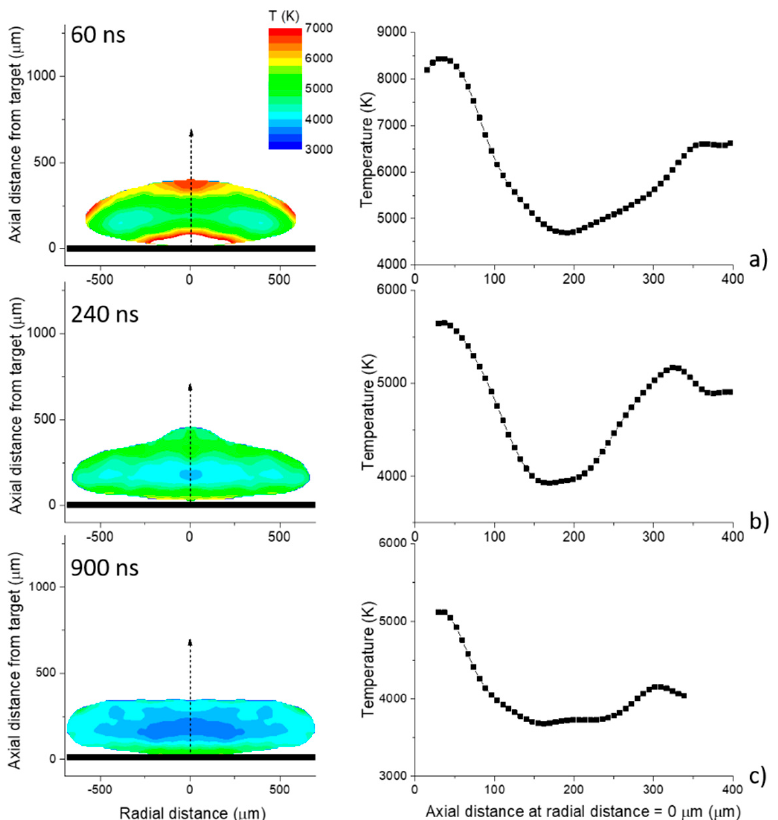
Figure 5. Temperature maps of LIP induced on Ti target immersed in water ( left ) and the corre- sponding axial temperature profiles at radial distance = 0 µ m along the expansion axis of the plasma ( right ) at delay times from the laser pulse ( a ) 60 ns, ( b ) 240 ns and ( c ) 900 ns, respectively. (Laser pulse width = 6 ns, laser energy = 270 mJ, laser wavelength = 532 nm, laser frequency = 10 Hz, crater size = 1 ± 0.2 mm, ICCD gate width = 20 µ s, 100 accumulations for each image) .